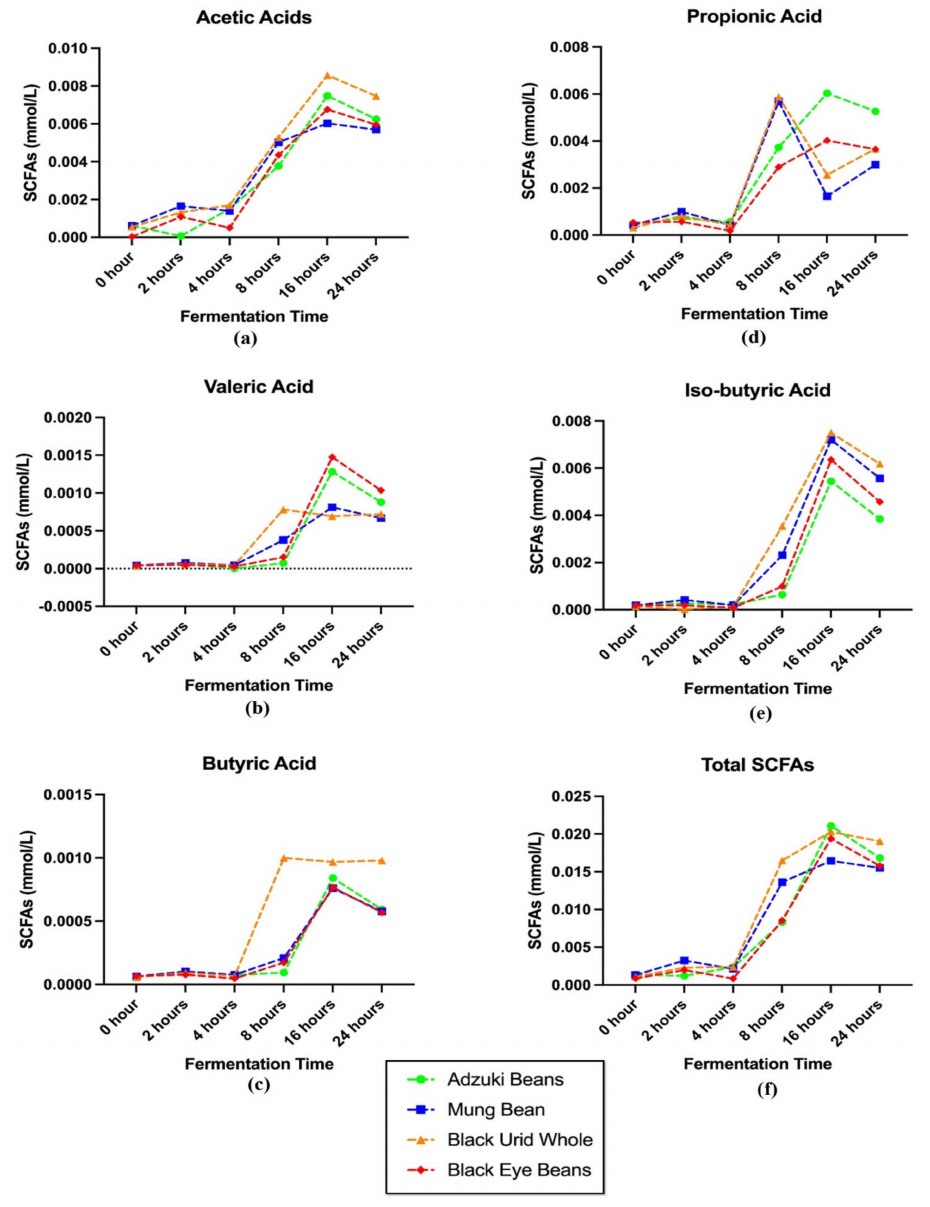
Figure 4. The trend of SCFAs production in different legumes digesta after complete colonic fer- mentation. ( a ) The level of acetic acid in legumes digesta; ( b ) the level of valeric acid in legumes digesta; ( c ) the level of butyric acid in legumes digesta; ( d ) the level of propionic acid in legumes digesta; ( e ) the level of iso-butyric acid in legumes digesta; ( f ) the level of total short chain fatty acids in legumes